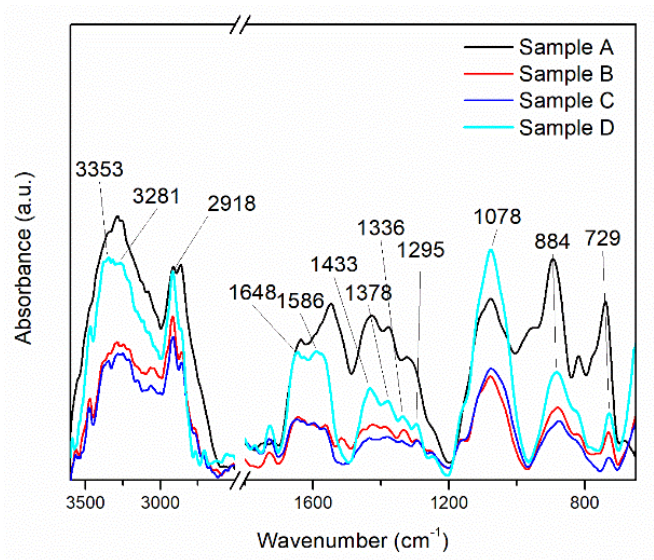
Figure 2. This FT − IR spectra of the MAPLE deposited CNT-Chit-FePc composite from different targets: Sample A (target containing (15% CNT + 1% Chit + 1% C 32 H 16 FeN 8 ) in H 2 O); Sample B (target containing (15% CNT + 1% Chit + 0.4% C 32 H 16 FeN 8 ) in H 2 O); Sample C (target containing (22% CNT + 1% Chit + 0.4% C 32 H 16 FeN 8 ) in H 2 O); Sample D (target containing (22% CNT + 1% Chit + 1% C 32 H 16 FeN 8 ) in H 2 O).